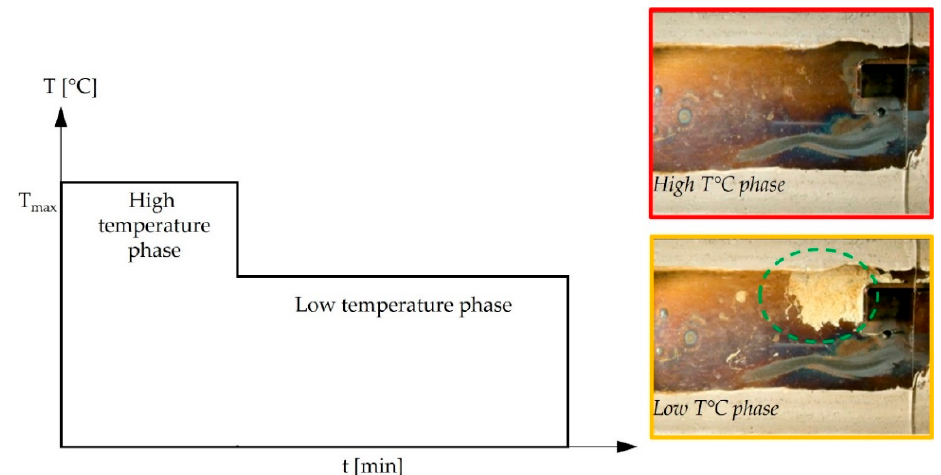
Figure 3. Graphic representation of the test cycle for the corrosion experiment.